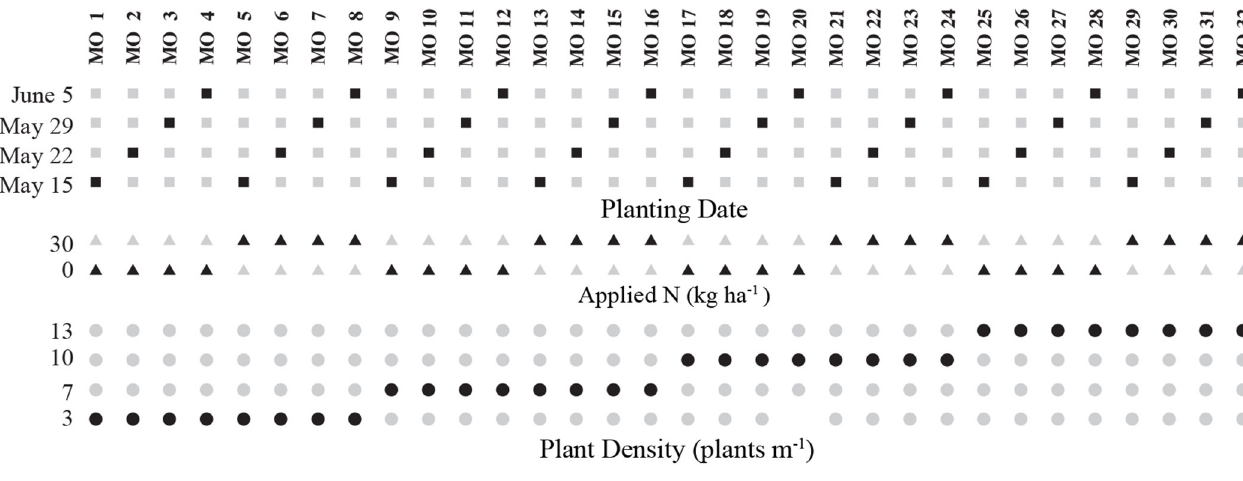
TABLE 1 | The 32 management options modeled in the CROPGRO-Cotton